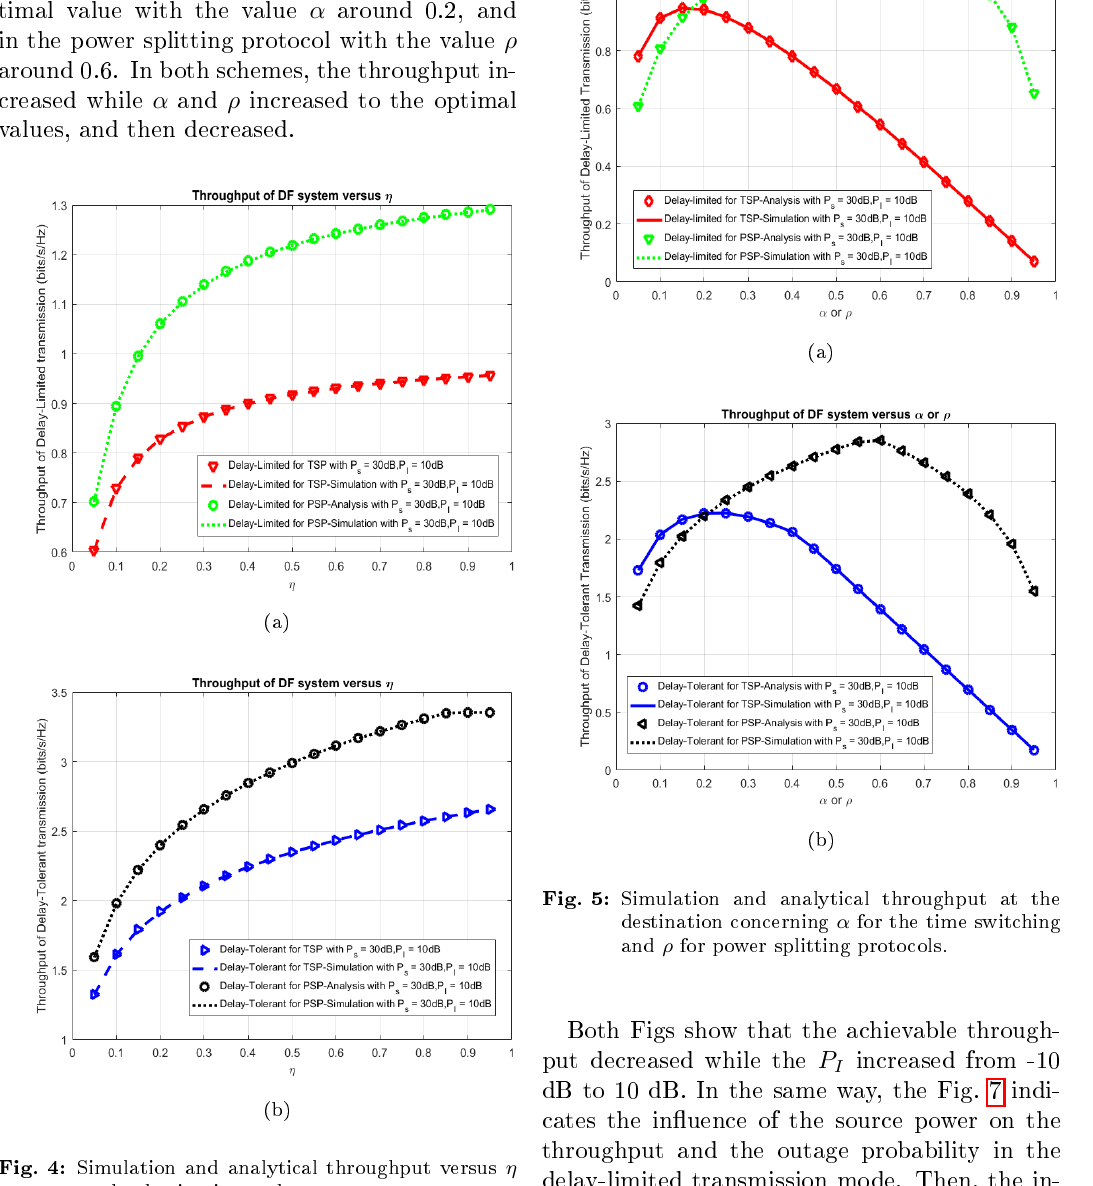
For more detail analysis, Fig. 6(a)plots the de- pendent of the throughput on the interference power P I in the delay-limited transmission mode and for the delay-tolerant transmission mode in the Fig. 6(b) for the time switching and the power splitting protocols, respectively.